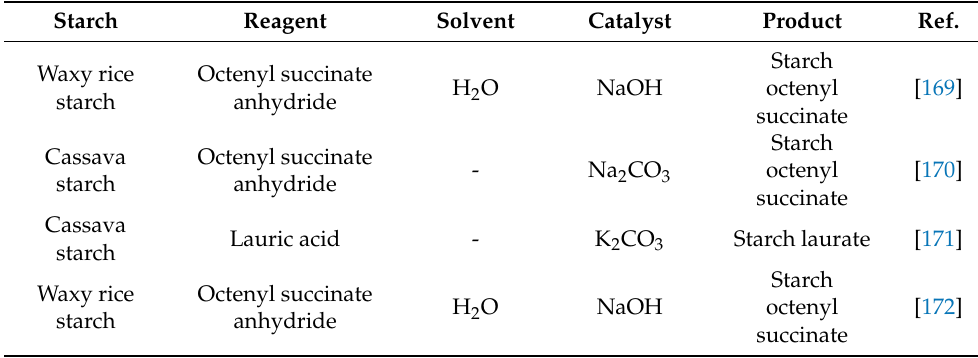
Table 5. Modification of starch by mechanochemistry method.